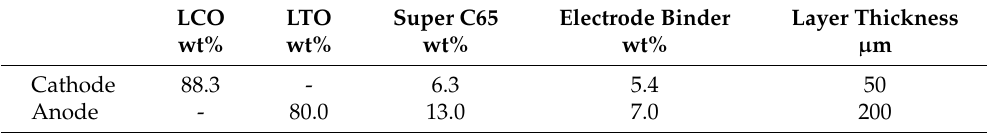
Table 1. Chemical composition of the electrode slurry and the applied layer thickness.